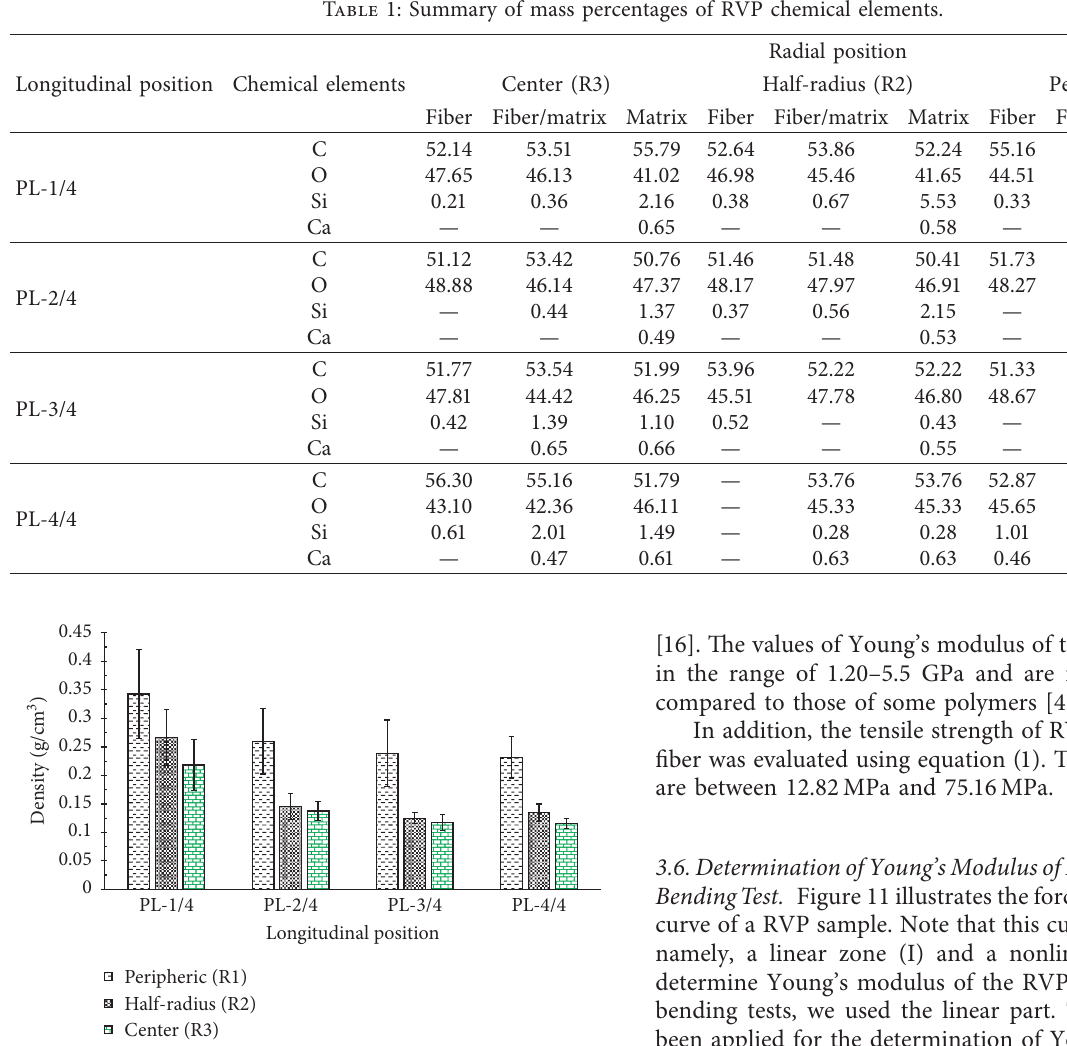
Figure 6: Evolution of the bulk density of the RVP along the